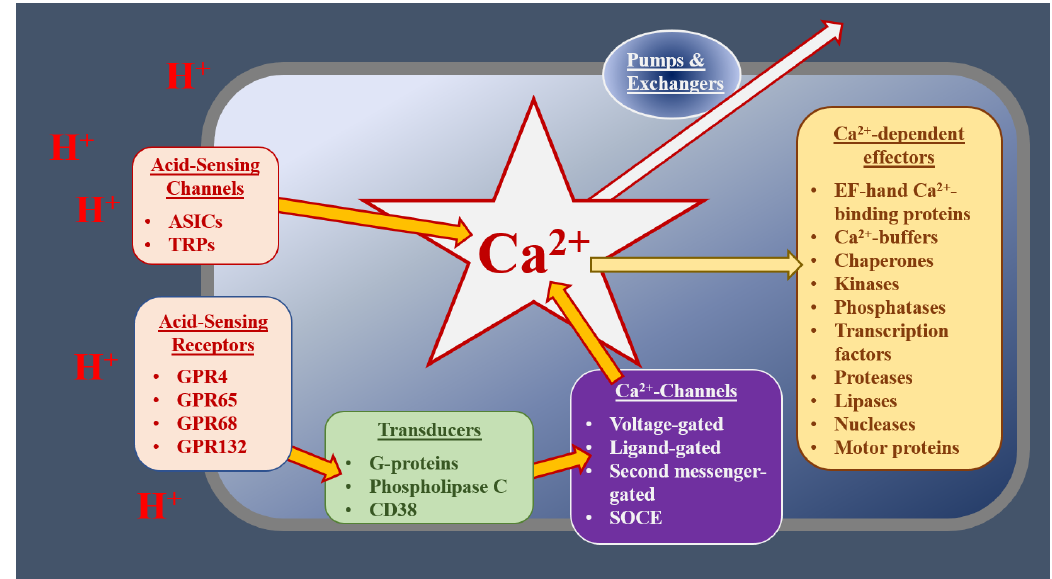
Figure 1. The potential role of the Ca 2+ toolkit in OAC cells. At the cell surface, extracellular cues, such as decreases in extracellular pH (increased [H + ]), are detected by receptors or cation channels, which gate to allow Ca 2+ influx. GPRs activate